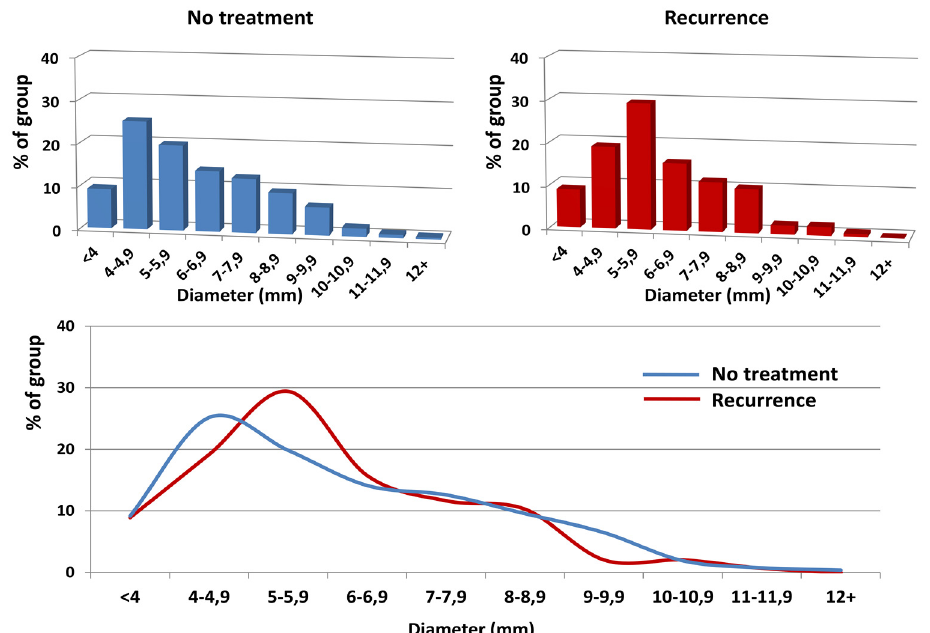
Figure 3. The distribution of the right ovarian vein diameters (horizontal axis) in regards to their frequency (vertical axis) in the analyzed groups. The upper graphs show the distribution in each group; the lower graph shows the overlaid data from the upper graphs. Despite a marked shift in the prevalence of the ROV diameters towards patients with a diameter >5 mm in the “Recurrence” group, this difference appeared non-significant (OR 1.34; 95% CI 0.86–2.08; P = 0.19).